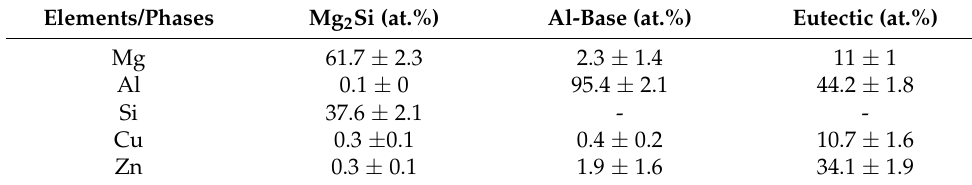
Table 9. Phases composition of the manufactured alloy in sample 1MH obtained by EDS.